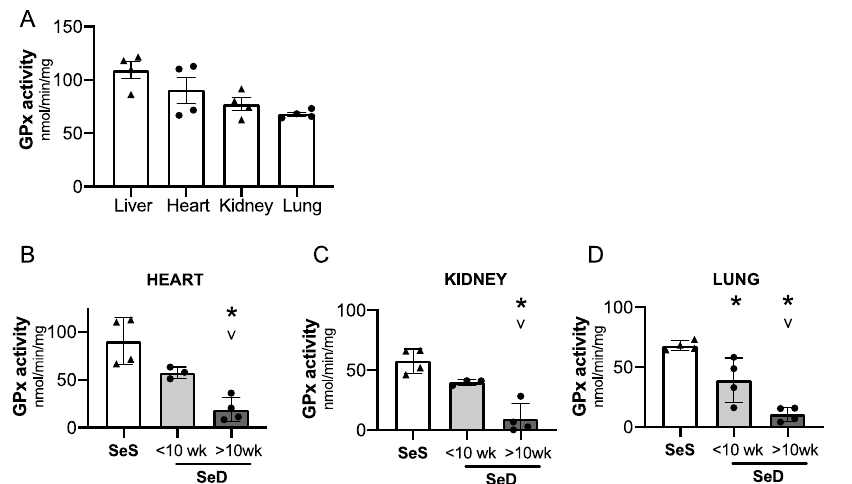
Figure 7. Neonates born to dams with prolonged Se deficient exhibit decreased pulmonary, renal, and cardiac GPx activity. C57Bl/6 mice were placed on diets that differed only in Se content, either 0.4 ppm or <0.01 ppm of sodium selenite. Breeding was initiated after 2–4 weeks on diet and natural delivery was allowed. Hepatic, cardiac, renal, and pulmonary organ homogenate was evaluated on day of birth. Each data point represents either a female or male from each litter. ( A ) Glutathione peroxidase (GPx) activity level by oxidation of NADPH per minute per milligram of protein in Se sufficient liver, heart, kidney, and lungs. ( B ) Cardiac glutathione peroxide activity level by oxidation of NADPH per minute per milligram of protein. ( C ) Renal glutathione peroxide activity level by oxidation of NADPH per minute per milligram of protein. ( D ) Pulmonary glutathione peroxide activity level by oxidation of NADPH per minute per milligram of protein N = 4 for all groups. Data and presented as mean ( ± SEM), * p < 0.05 vs. SeS control, by multiple comparison after one-way ANOVA, ∨ p < 0.05 vs. SeD <10 weeks by multiple comparisons after one-way ANOVA.